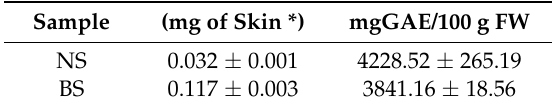
Table 1. Total phenol content and radical scavenging activity in natural (NS) and blanched (BS) almond